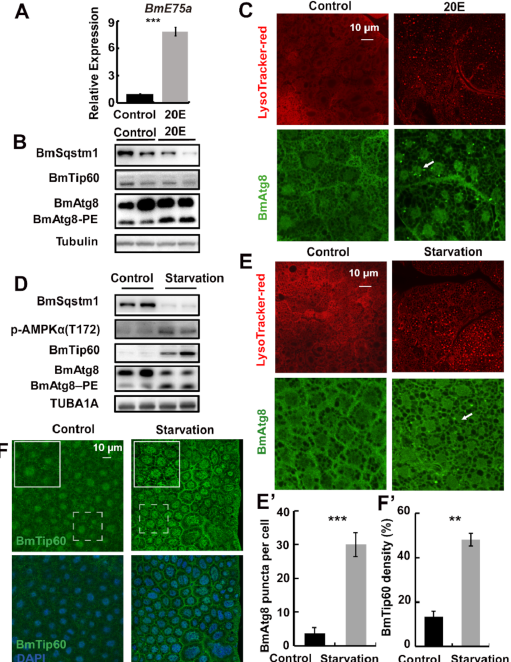
Figure 1. Starvation but not 20-hydroxyecdysone (20E) promotes BmTip60 in addition to autophagy in B. mori fat body. ( A ) mRNA levels of BmE75a after 20E treatment for 24 h. ( B ) Protein levels